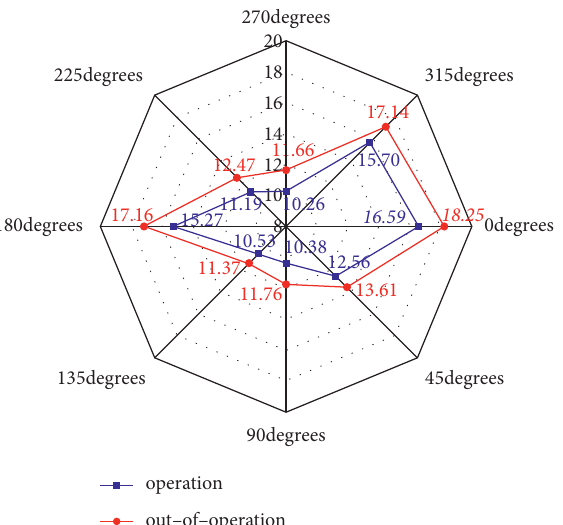
Figure 10: Maximum deformation of lattice columns in different orientations of the tower arm in operation condition and out-of-operation condition